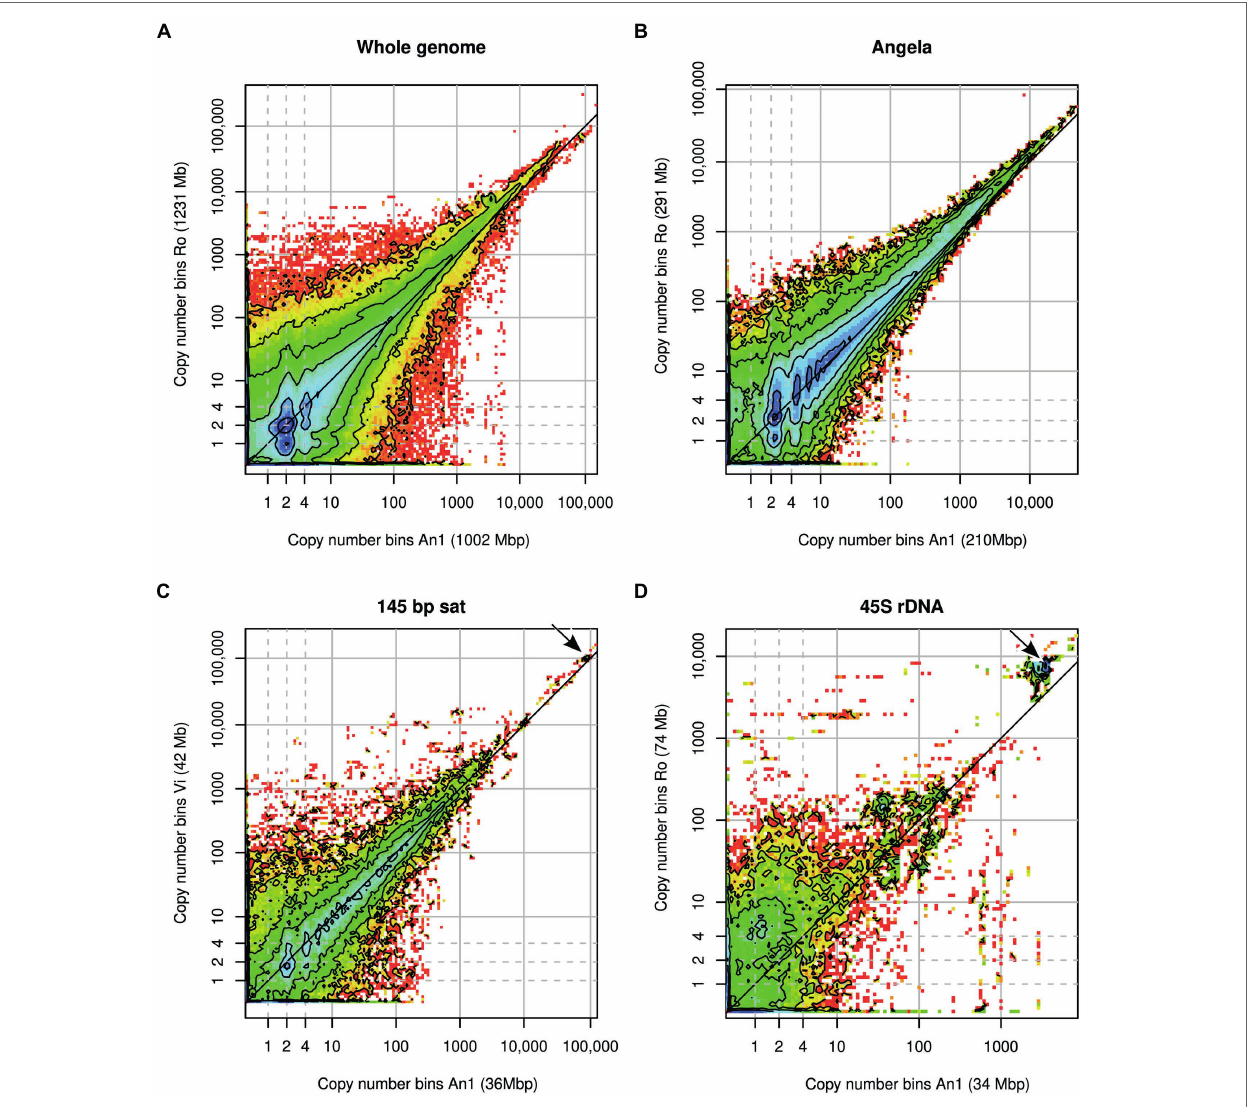
FIGURE 4 | Heatmaps of binned joint k-mer spectra in comparative analyses of Euphrasia genomic sequences. (A) shows the comparison of whole genomes. The other panels show k-mers associated with specific genomic repeats: (B) Angela LTR retrotransposon, (C) 145-bp satellite, (D) 45S rDNA. Copy number bins of the reference individual are shown on the x -axis. The axis labels show in parentheses the contribution of the k-mer fraction depicted to each individual’s overall genome size. The dashed grey lines indicate haploid, diploid and ‘duplicated’ copy numbers. The dark grey diagonal line in each plot indicates the zone where copy numbers are equal between the samples. The arrows in panels (C,D) indicate k-mer clusters responsible for the gap patterns in Figure 3B and Figure 3C